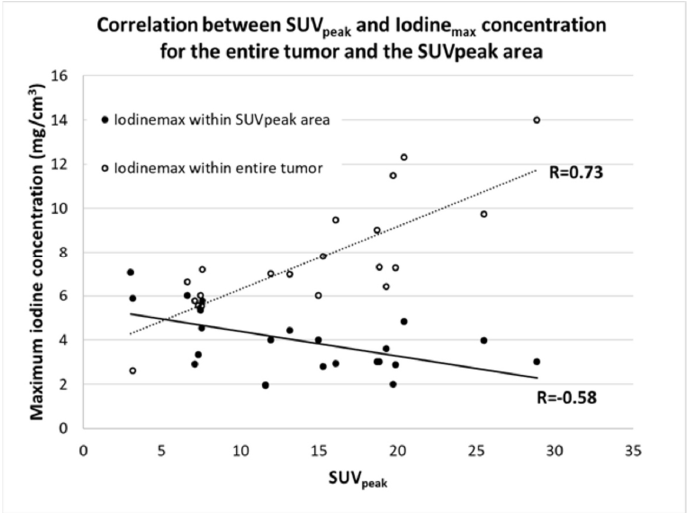
Figure 4. Scatter plot showing the correlation between the SUV peak and the maximum iodine concentration (Iodine max ) found in the tumor, and only in the SUV peak area. There was a significant positive correlation ( p = 0.0001) between the SUV peak and the Iodine max found in the tumor. However, when the maximum iodine concentration was taken from the same area as the SUV peak (1 cm 3 sphere), a significant negative correlation ( p = 0.005) was found.